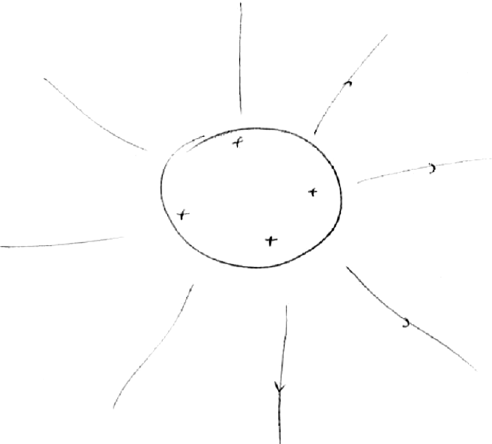
FIG. 3. Student sketch of the electric field of a charged cylinder [question